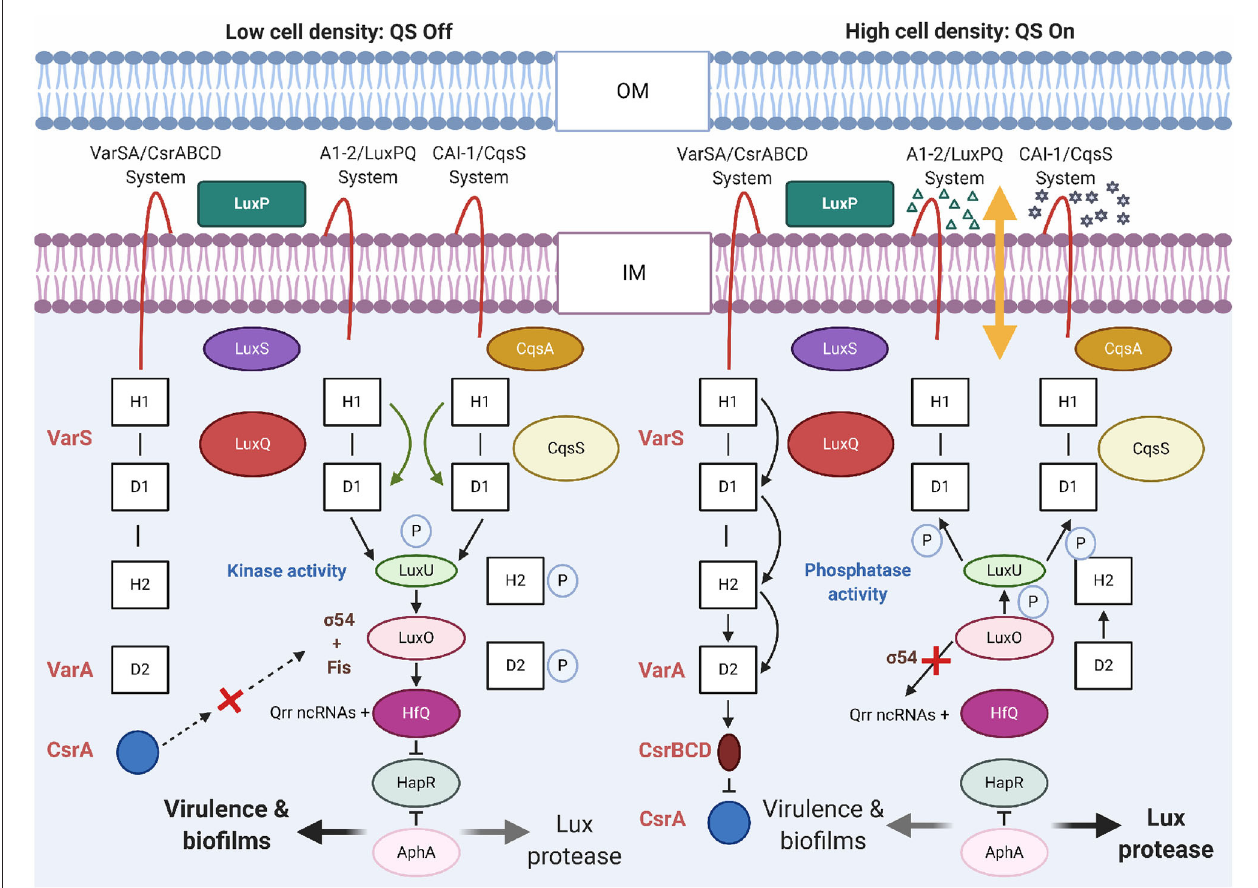
FIGURE 6 | Quorum sensing circuits in V. cholerae . In V. cholerae , QS outcome depends on the cell density. At a low cell density (LCD), QS will be in a switch-off mode. With low autoinducer concentration, the membrane proteins LuxPQ and CqsS act as kinases and direct phosphate (P) through LuxO to LuxU. With σ 54 of RNA polymerase, LuxO initiates transcription of genes encoding regulatory Qrr ncRNAs. The Qrr ncRNAs activate translation of AphA and with Hfq, it represses translation of HapR. The above mentioned conditions promotes expression of genes encoding virulence factors and biofilm formation. At a high cell density (HCD), the QS will be in a switch-on mode. At this phase, the autoinducers are accrued, AI-2 ( 1 ) and CAI-1 ( ⋆ ) bind to their respective receptors LuxPQ and CqsS. Binding of AI act as phosphatases to reverse the flow of phosphate (P) across the regulatory circuit and deactivate LuxO. As a result, the Qrr ncRNAs are not formed and hence, HapR translation is not repressed and AphA translation is not activated. HapR represses the virulence-related functions. Other receptors, VarSA/CsrABCD with unknown ligands, also transduce QS information through LuxU. DNA-binding protein Fis functions together with AI-2/LuxPQ, CAI-1/CqsS, and